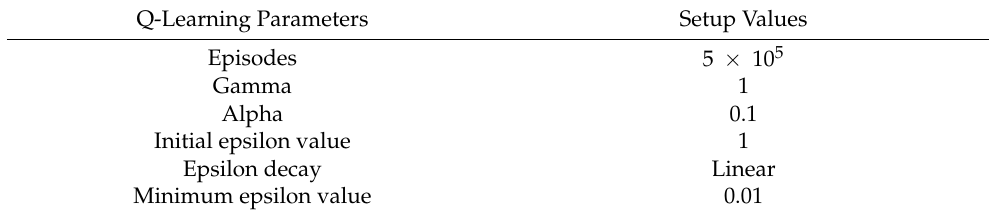
Table 7. Q-Learning parameters setup values.